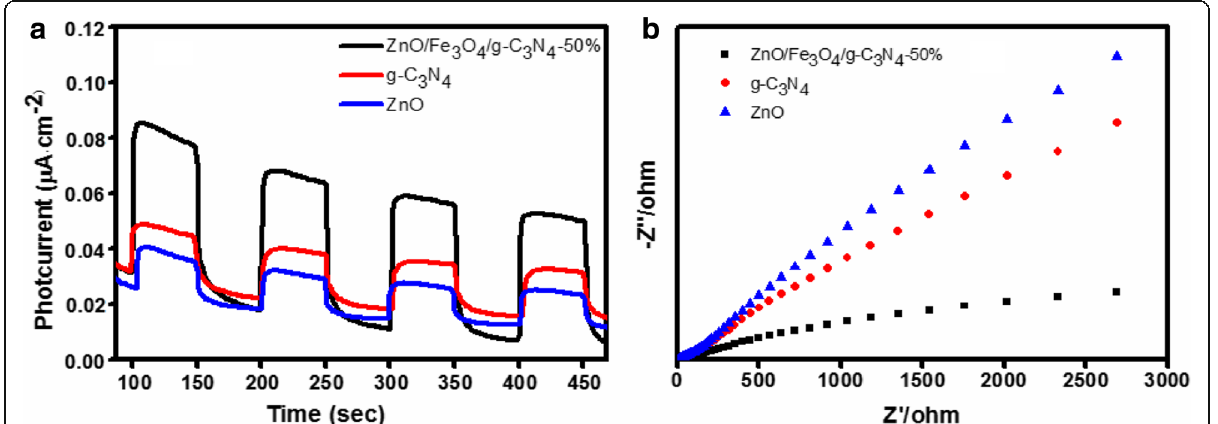
Fig. 7 Transient photocurrent response ( a ) and EIS plots ( b ) ZnO, g-C 3 N 4, and ZnO/Fe 3 O 4 /g-C 3 N 4 -50% under visible-light irradiation